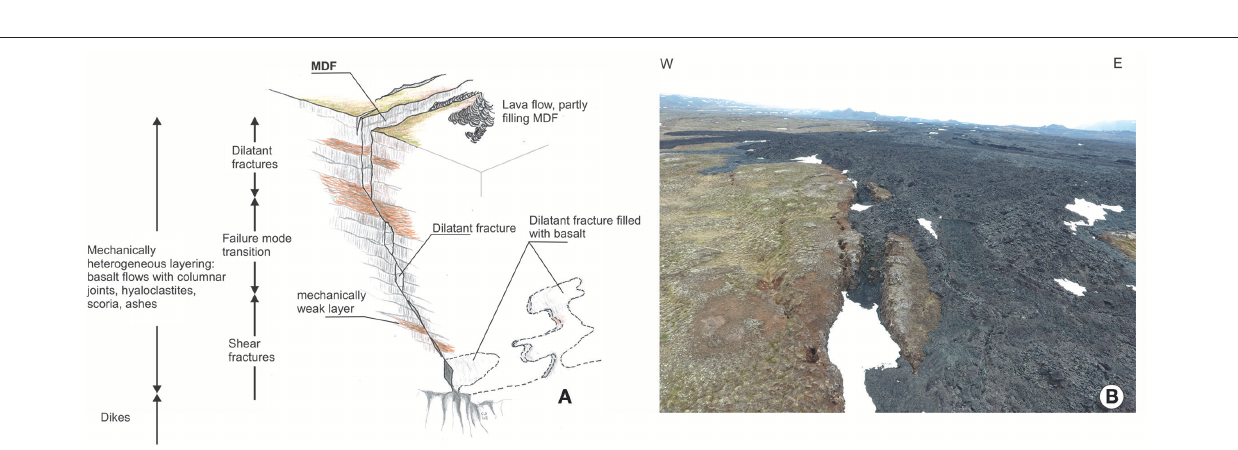
FIGURE 14 | (A) Conceptual model of the results applied to a rift (not to scale). In the uppermost section down to a depth of up to 800m only dilatant fractures occur in cohesive rocks. Below this critical depth, transition to shear fracturing can be observed. Dilatant parts of the fault are isolated patches. Location of these patches depends on the heterogeneity and mechanical stratigraphy of the rock column. At greater depths elevated pore pressures may result in Mode 1 fracturing. The depth below which only shear fracturing can occur is unknown. If extension is large enough the surface fracture connects with the dike system at depth and may guide magma ascent. This can result in fissure eruptions and lava flows filling the MDF (B)